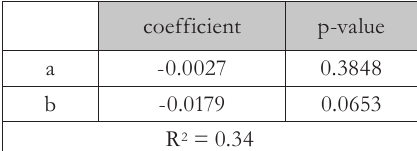
Tab. 1 – OLS estimation of beta-convergence equation for 27 European Union countries.